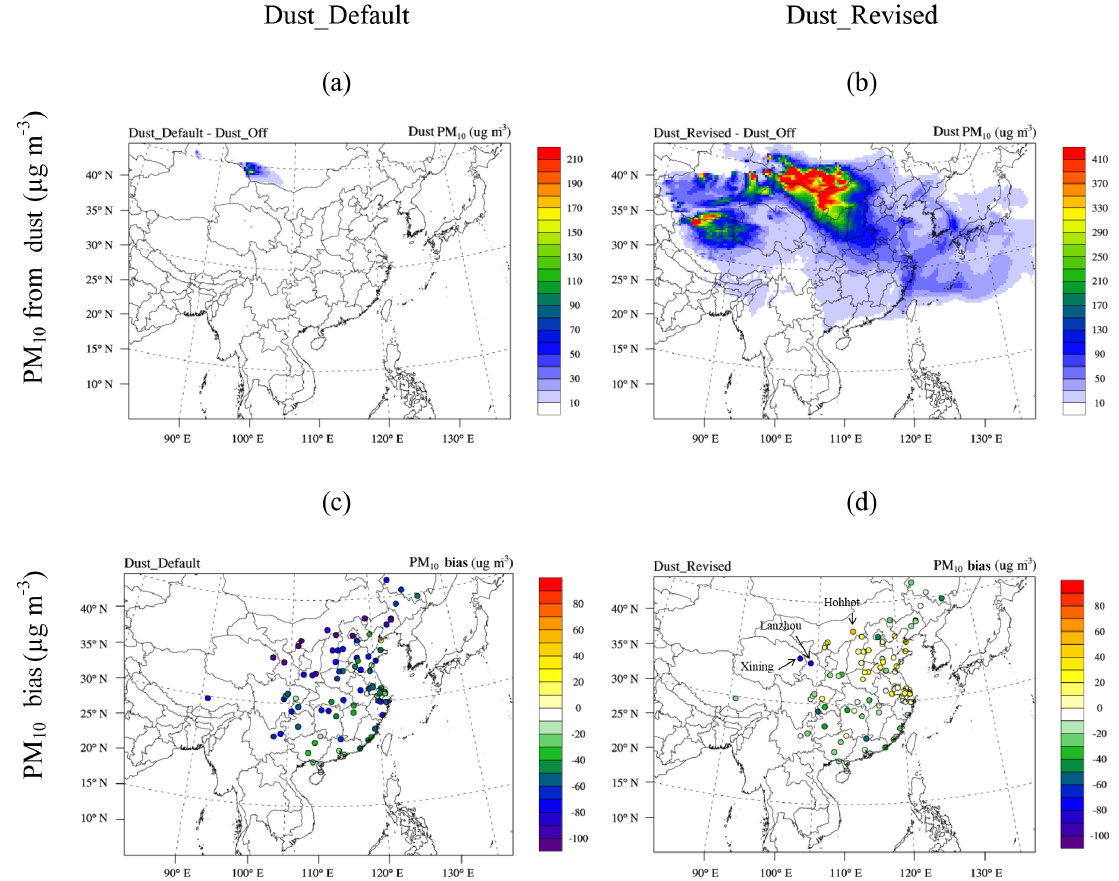
Figure 3. Five-year averages of PM 10 concentration difference from (a) Dust_Default – Dust_Off and (b) Dust_Revised – Dust_Off. PM 10 simulation bias against observation at API stations for (c) Dust_Default and (d) Dust_Revised